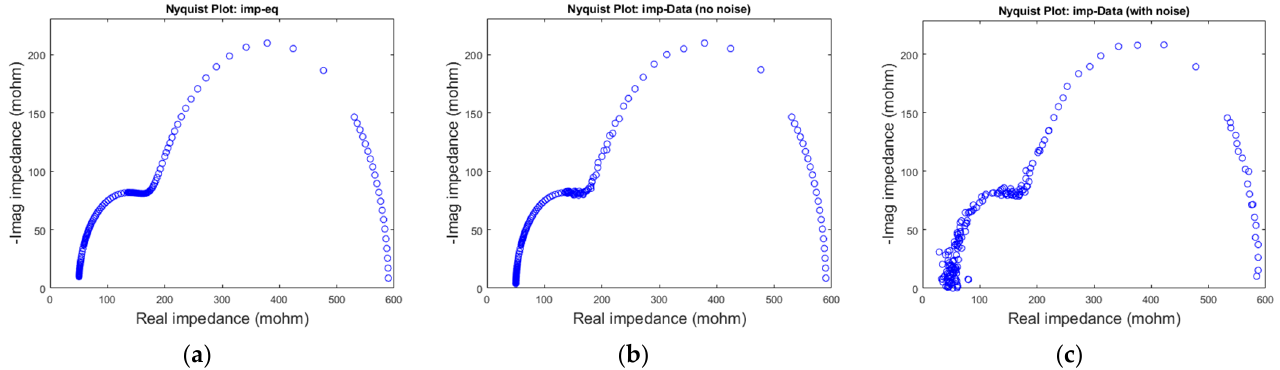
Figure 5. Nyquist plot by simulations using models. ( a ) Equation based EIS. ( b ) Simulation results (no noise). ( c ) Simulation results (with noise).